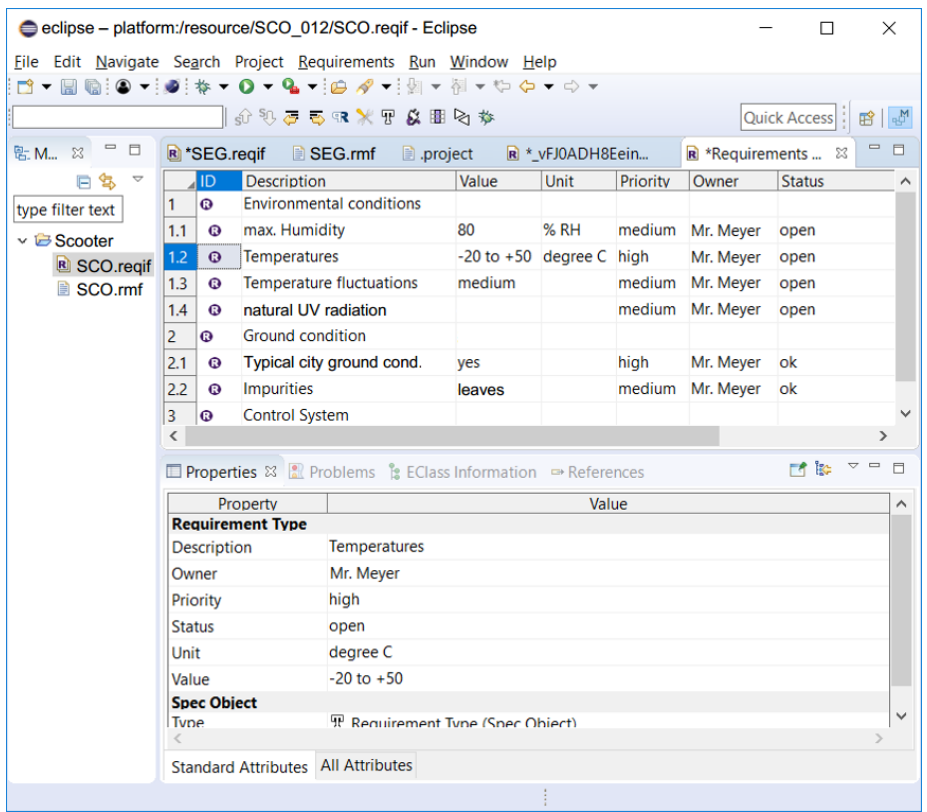
Figure 6. Requirements management with Eclipse “ProR”—example.